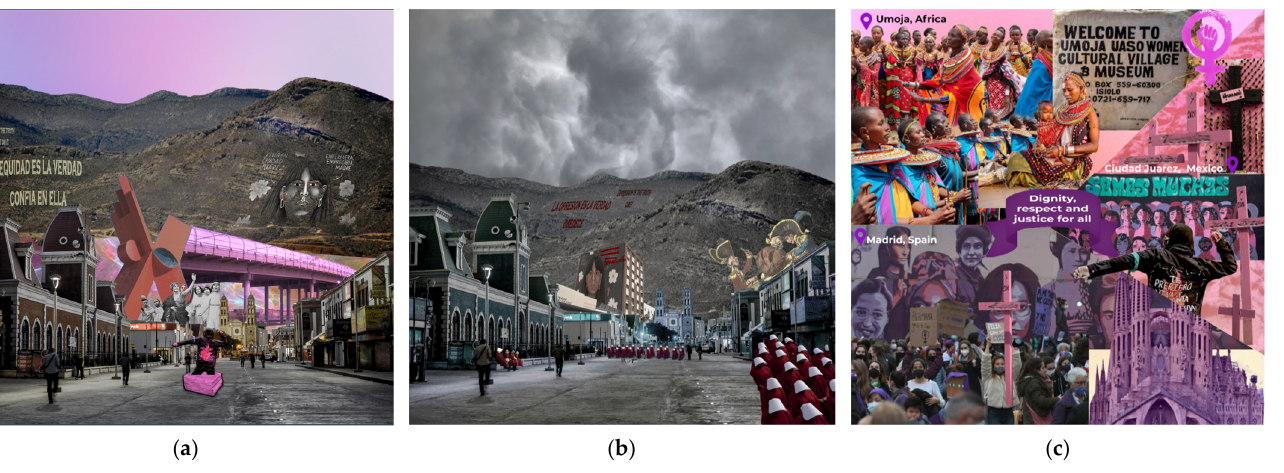
Figure 3. Radical femininity, Ciudad Juarez, Chih, Mexico. From left to right: ( a ) utopian Ciudad Juarez poster, ( b ) dystopian Ciudad Juarez poster both created by Natalia Dominguez, 2022 ( c ) fem‑ inism worldwide, created by Natalia Dominguez, Elizabeth Fuller and Macy Morris, 2022.